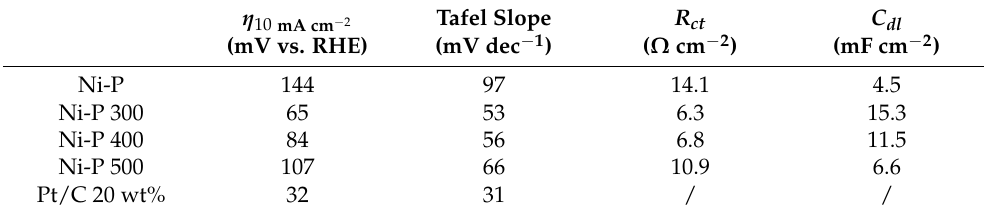
Figure 5. ( a ) iR -corrected LSV curves, ( b ) Tafel plots, ( c ) comparison of the Tafel slopes and η 10 and ( d ) the Nyquist plots measured at − 0.02 V vs. RHE for the Ni-P and Ni-P that crystallized at different temperatures. Table 1. Summary of electrochemical parameters of different catalysts.